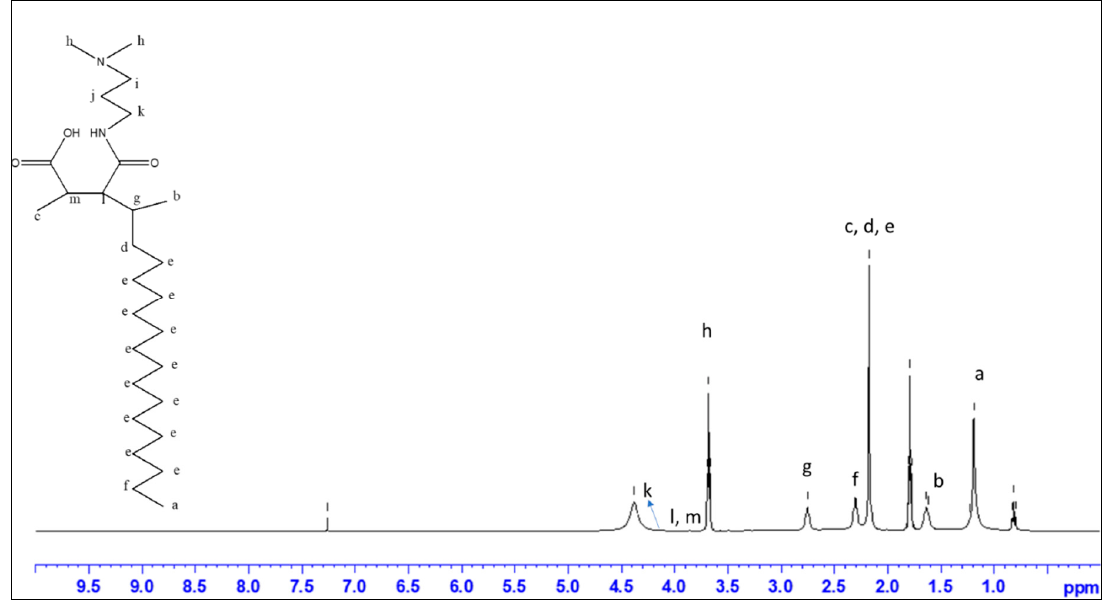
Figure 2. 1 H-NMR spectrum of the zwitterion p(MAO-DMPA).